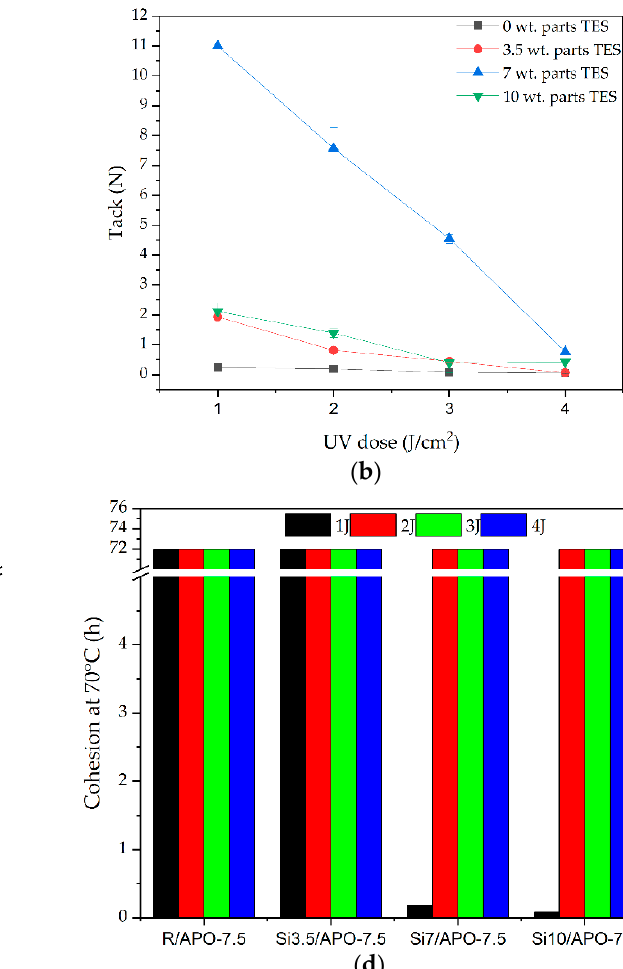
Figure 6. FT-IR spectra of TES, dry systems consisting of Si telomers (with the same content of 0.075 wt. parts APO), and dry reference with the same APO concentration.